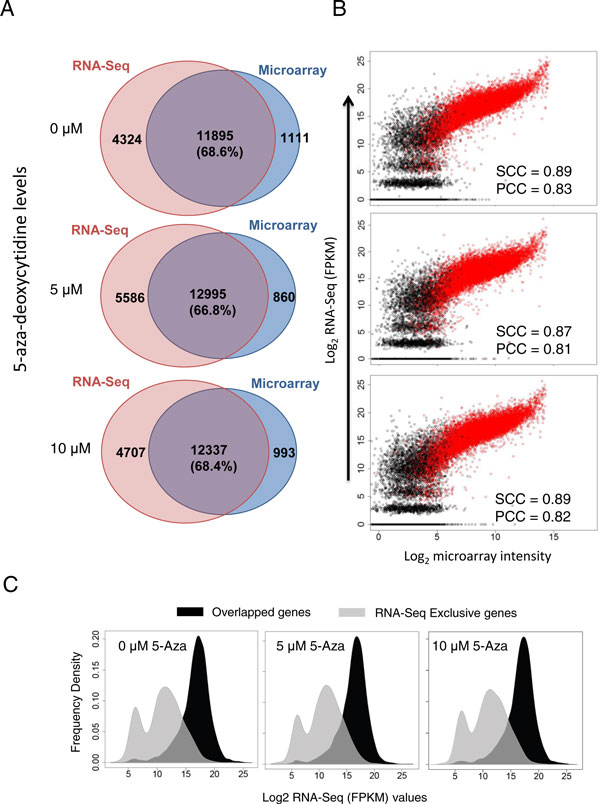
Expressional consistency between RNA-Seq and microarray data. A. Detectable genes reported by each technology based on a common filter procedure (See Methods). Venn diagrams of detectable genes are shown 3 experimental conditions (0 µM, 5 µM and 10 µM) respectively, and overlap rates are calculated by dividing number of commonly detectable genes by the union. B. By-group scatter plot depicting the expression profiles of all genes. Log2 transformed FPKM values from RNA-Seq and log2 scaled microarray gene intensities (normalized) are used in the scatterplot. We added 1 to FPKM value before log2 transformation to facilitate calculation. Commonly detected genes are shown in red color while platform exclusive genes are denoted in black. Both Pearson correlation coefficients (PCC) and Spearman correlation coefficients (SCC) were calculated based on all gene entries (except for those not having probe names on the array or RNA-Seq reference genome). C. By-group expressional density histogram for both commonly detectable genes and RNA-Seq specific ones. The x-axis denotes the RNA-Seq FPKM value (log2 scale) distribution and y-axis shows the frequency of genes within each category. Commonly detectable genes are depicted in black while RNA-Seq exclusive genes are shown in grey color.